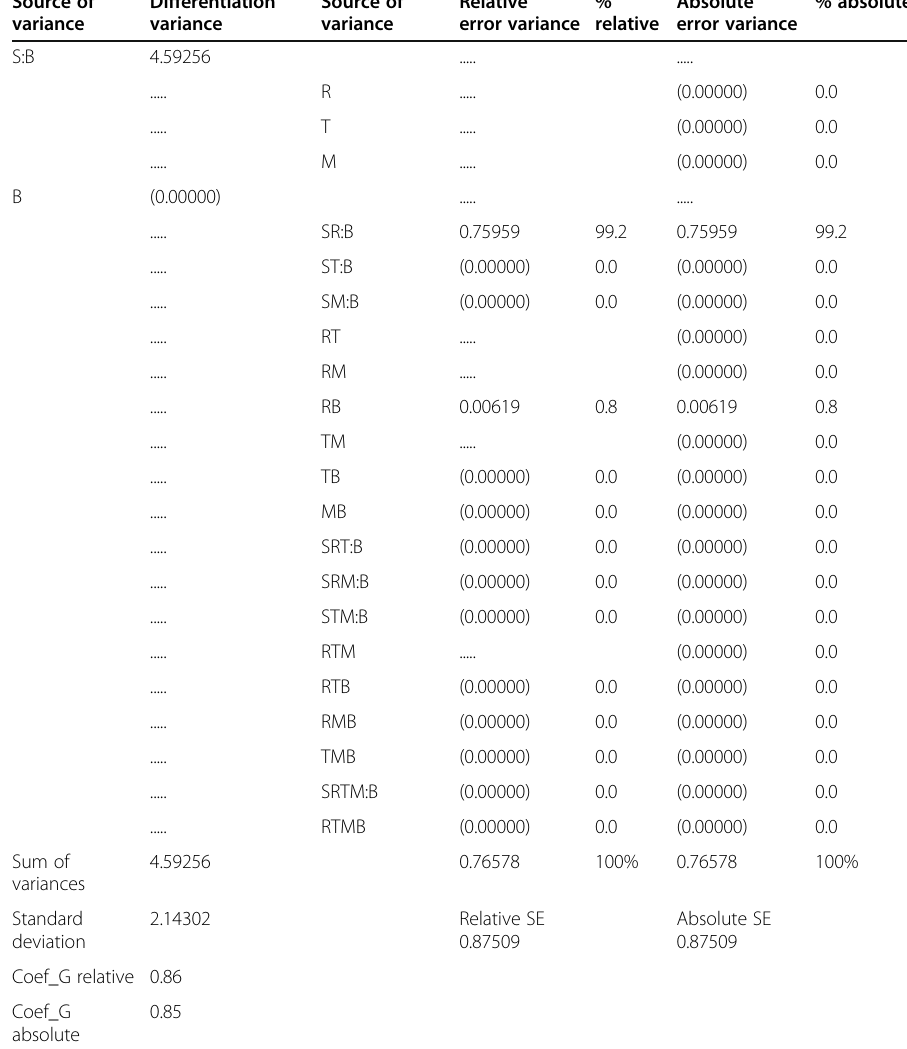
Table 5 G-study table. Measurement design (SB/TMR) Source of